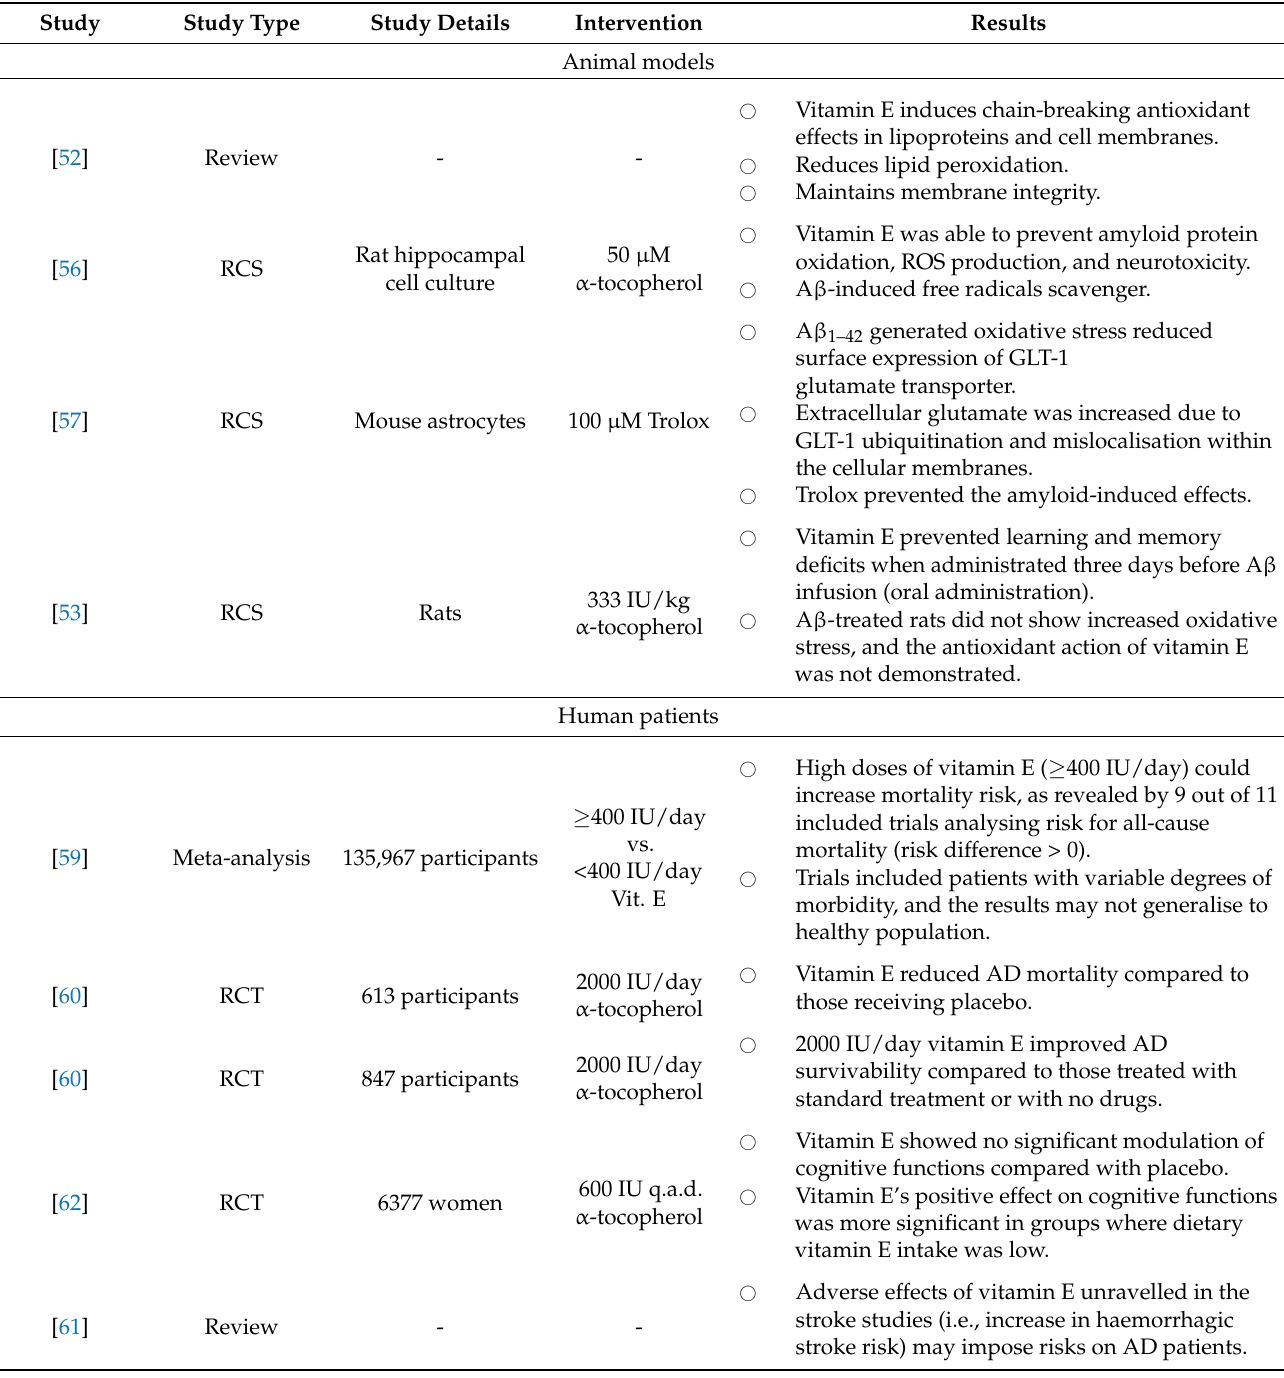
Table 1. The correlation between AD and vitamin E neuroprotective